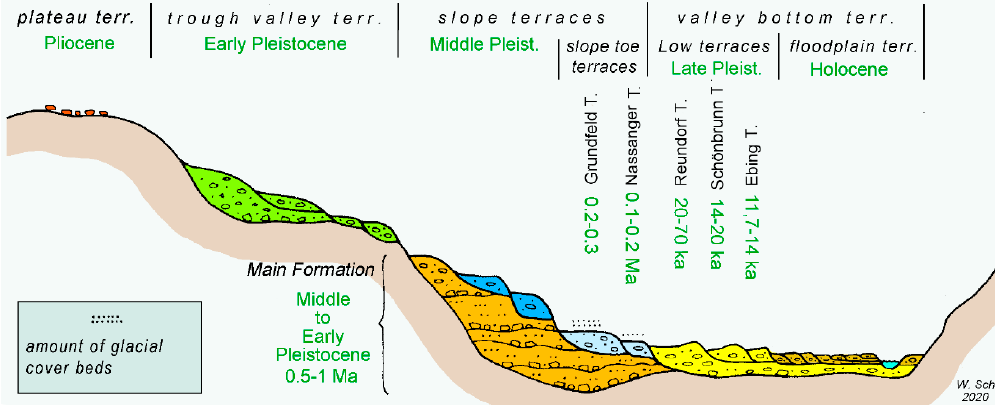
Figure 7. Scheme of the flument/terrace flight of the Main River and adjoining rivers in Central Europe. Not to scale. For the age of the Holocene terraces, see Figure 9. Location: Whole Main River.